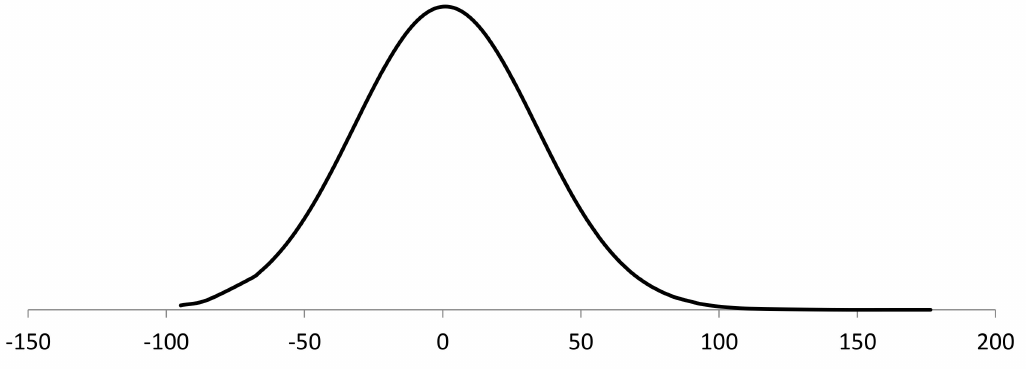
Figure 1. Distribution of the forecast